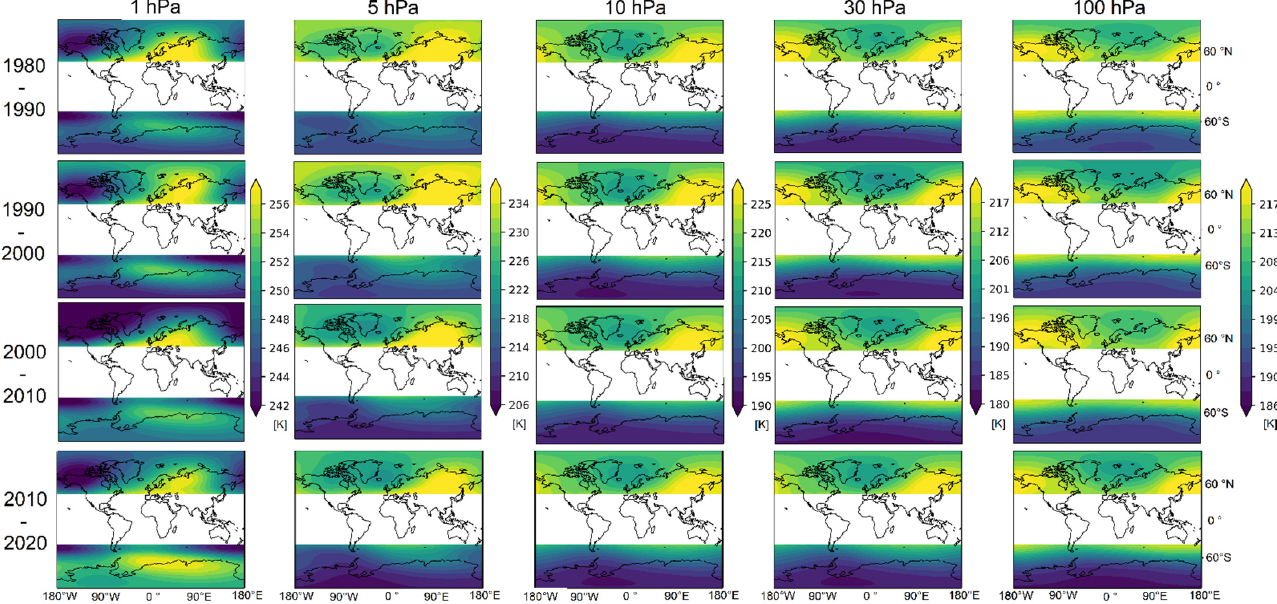
Figure 2. Temperature climatology (K) for 1980–1990, 1990–2000, 2000–2010 and 2010–2020 using ERA5 reanalysis at 1, 5, 10, 30 and 100 hPa.